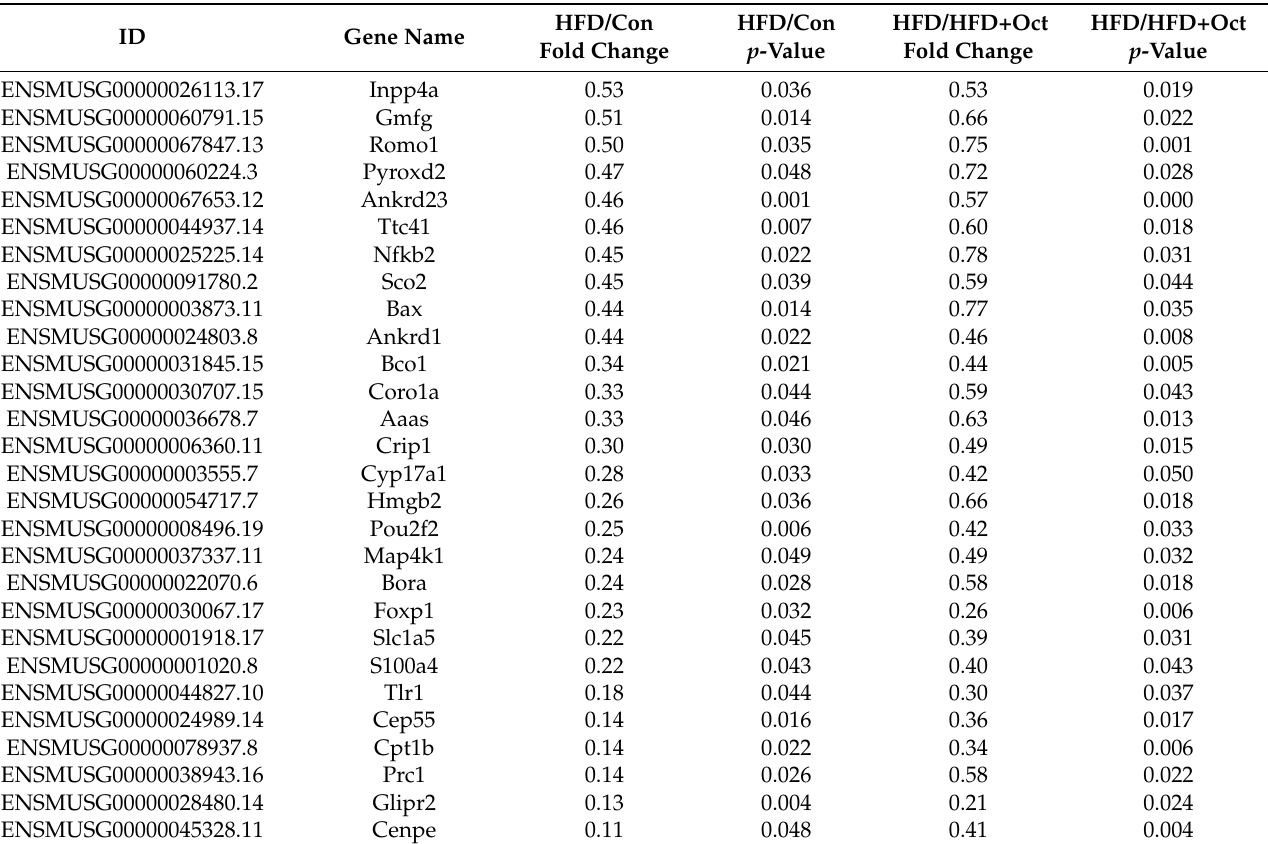
Table 1. Genes upregulated by Oct from gene chip